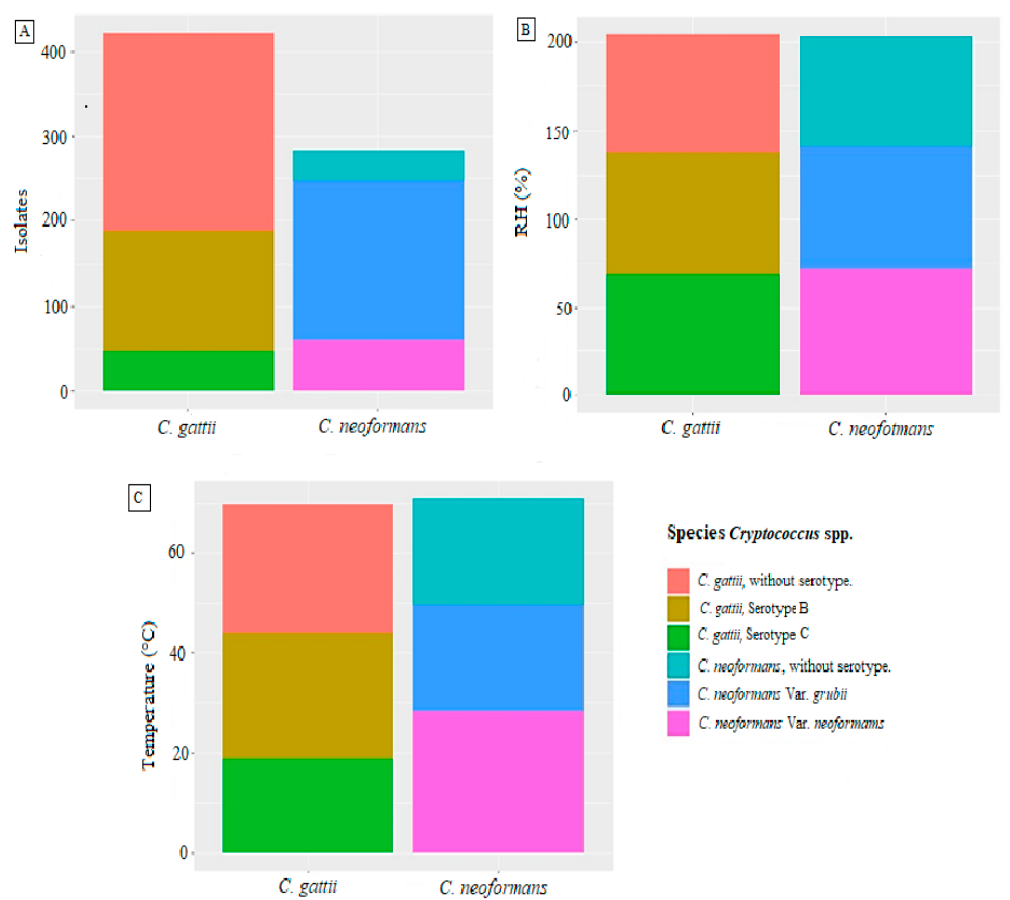
Figure 3. Environmental conditions reported for each species of Cryptococcus spp. ( A ) Numbers of isolates reported for each species (C. gattii and C. neoformans ), according to their respective varieties. ( B ) Percentages of relative humidity (RH) reported for the isolates of each species ( C. gattii and C. neoformans ), according to their respective varieties. ( C ) Temperatures (°C) reported for the isolates of each species ( C. gattii and C. neoformans ), according to their respective varieties. Source: The authors of this study; image created in RStudio.